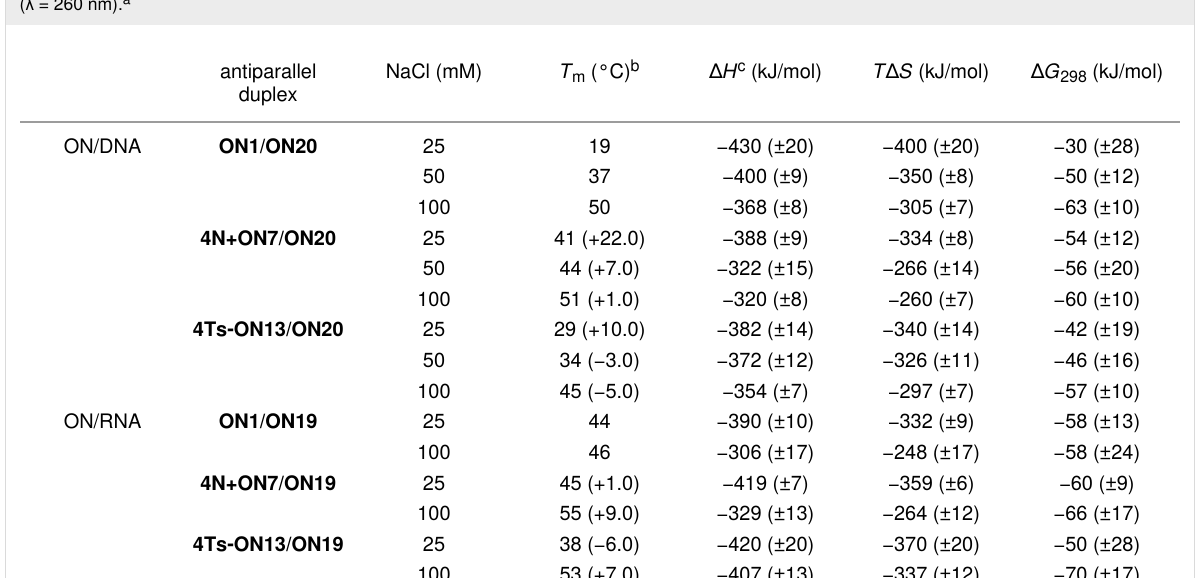
Table 3: The T m [°C] and thermodynamic data at 298 K for the antiparallel duplexes at different NaCl concentrations, taken from UV melting curves ( λ = 260 nm). a